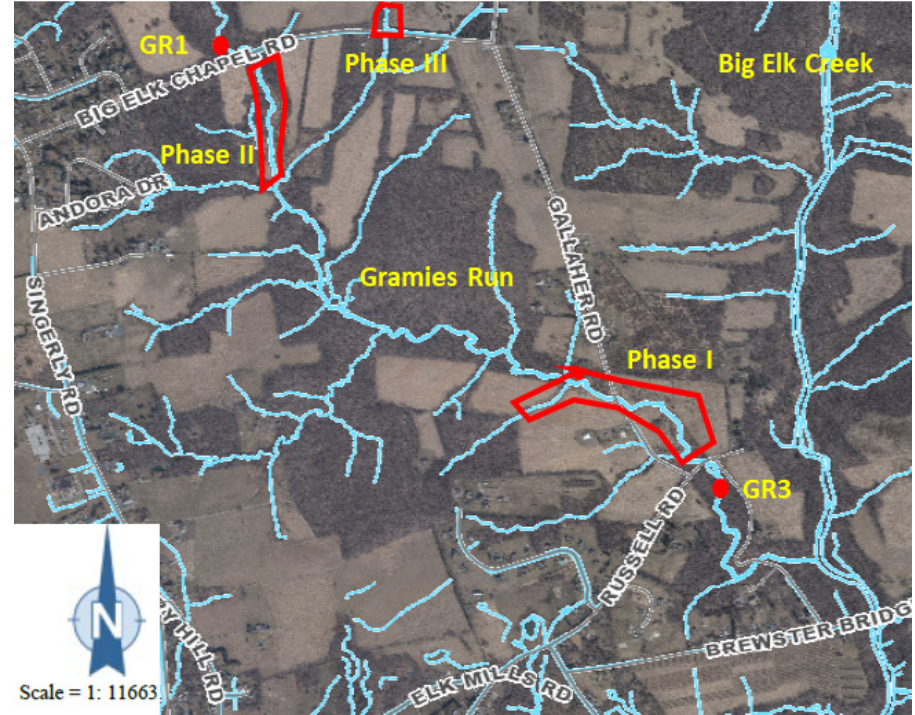
Figure 3. Aerial map indicating restoration phases (I–III) on the Gramies Run stream network. Sampling locations GR1 and GR3 (indicated by the filled red circles) are located upstream and downstream of the restoration reaches.